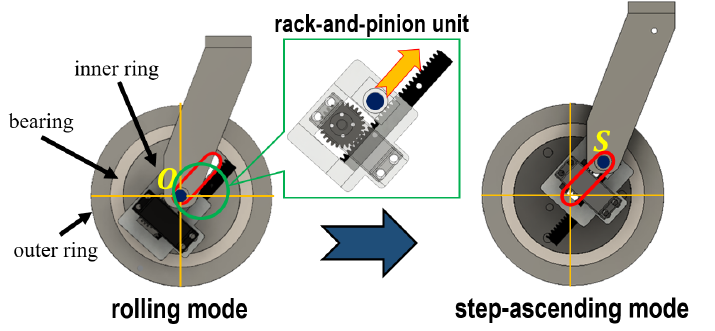
Figure 6. Implementation concept of axel-transitional process using rack-and-pinion unit.